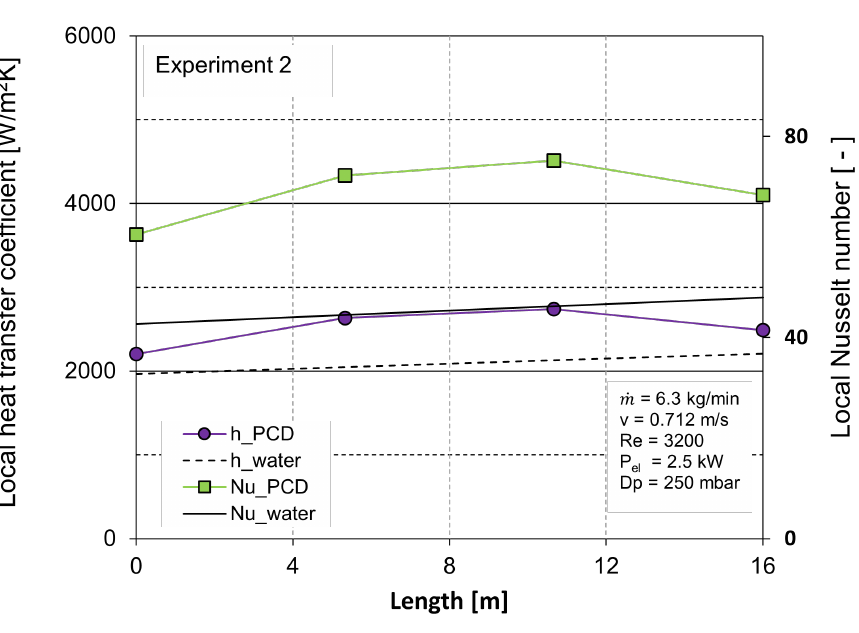
Figure 7. The local heat transfer coefficients and local Nusselt numbers for the PCD in experiment 2. Additionally, the local heat transfer coefficients and local Nusselt numbers for water at the same Reynolds number are